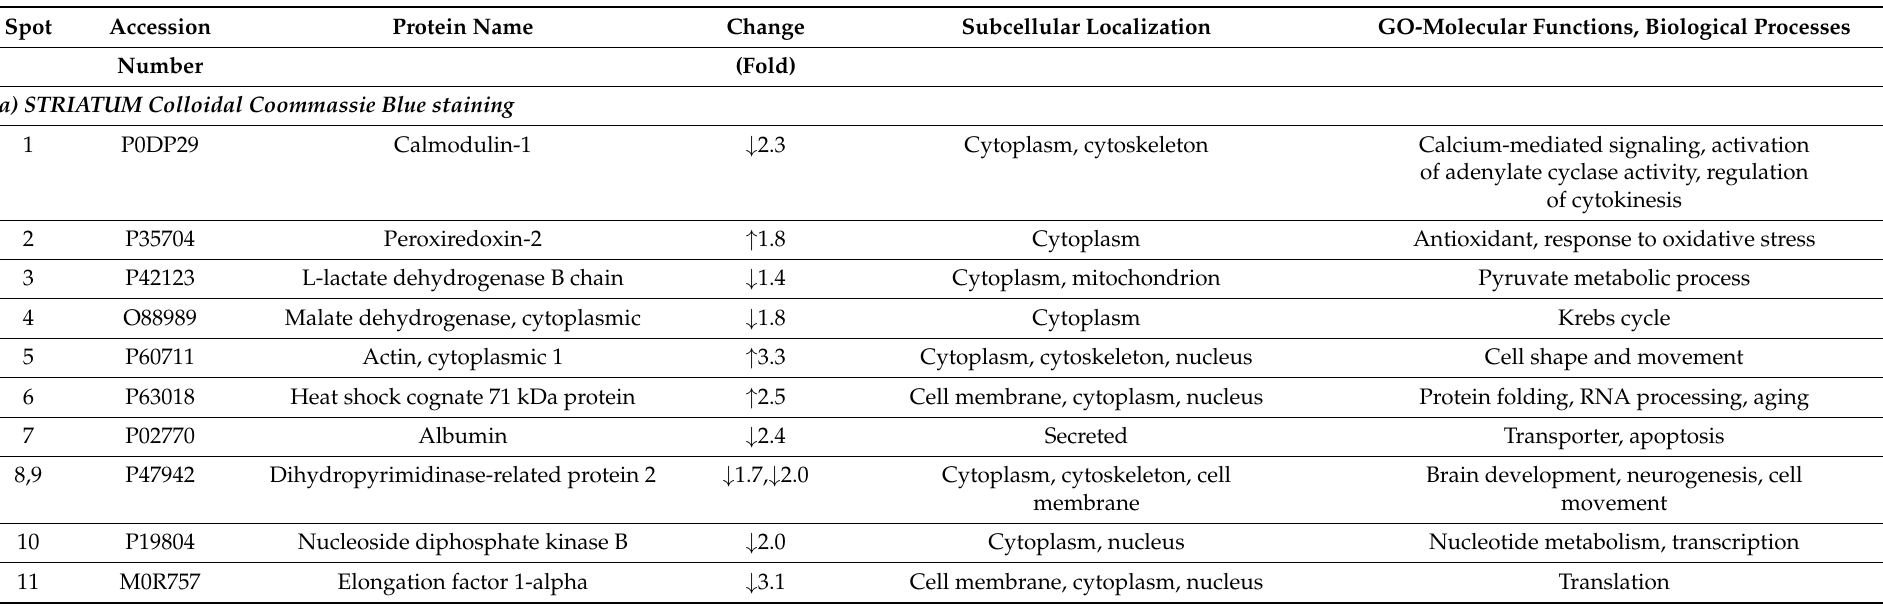
Table 6. Subcellular localization and function of altered proteins identified in the rat striatum ( a ) and cerebellum ( b ) isolated from animals after 6 months